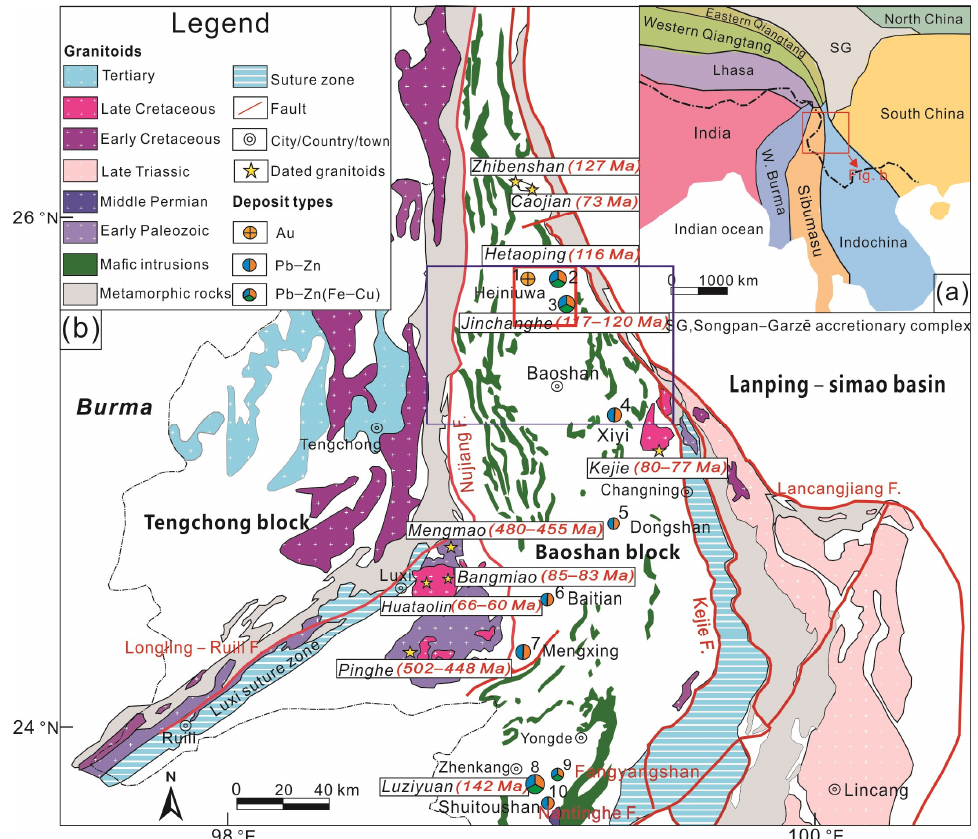
Figure 1. Sketch map showing the regional geology of the area under investigation. ( a ) Major continental blocks and suture zones in Southeast Asia (modified after [32]). ( b ) Simplified regional geologic map of the Baoshan block, showing the distribution of major structures, magmatic rocks, and ore deposits (modified after [19,28,31,33,34]).